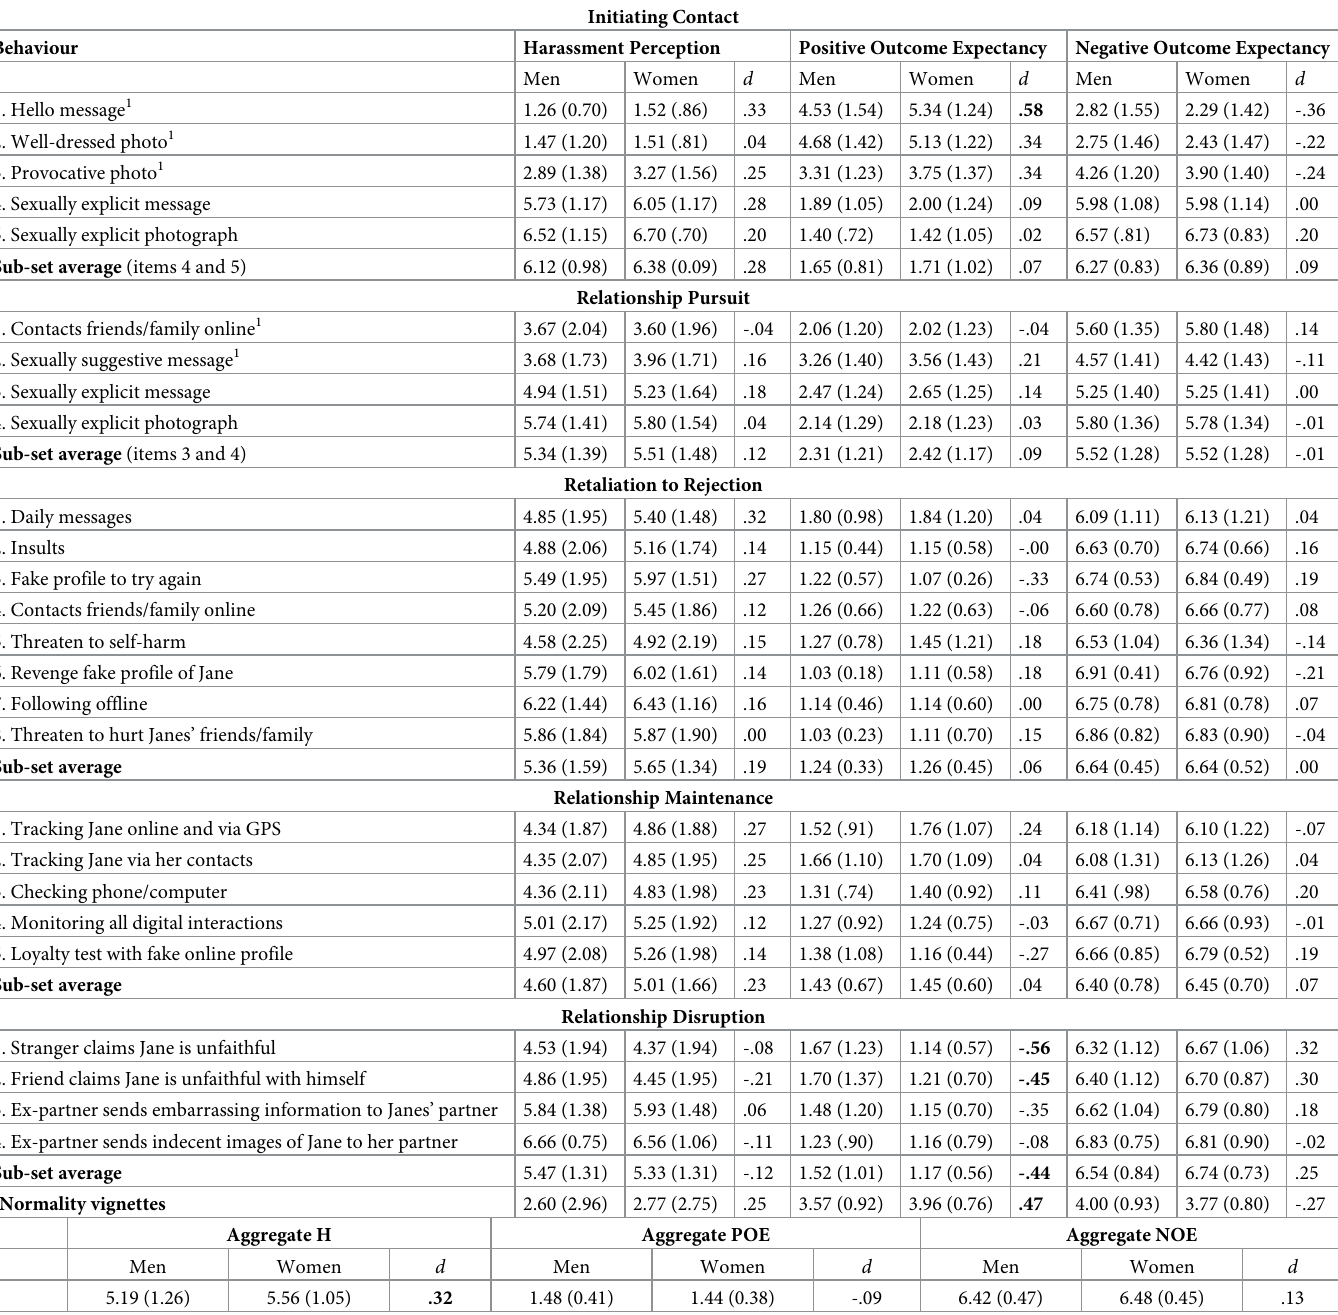
Table 1. Summary statistics for the individual vignettes of the Online and Digital Sexual Harassment Measure (OD-SHAM) for men and women are presented